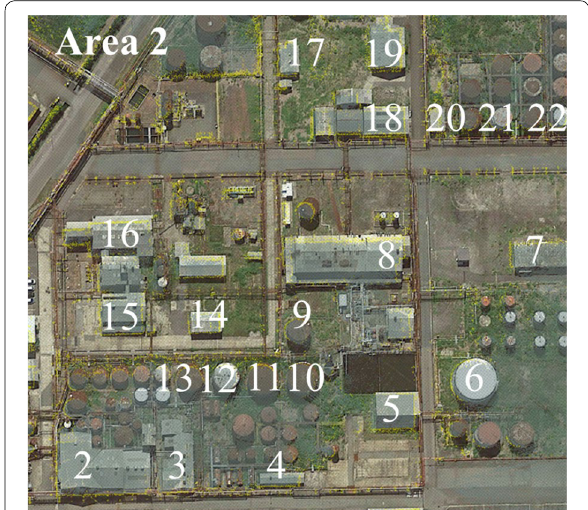
Fig. 6 Global consistency evaluation using an aerial map as a refer- ence. Each building position in the 2D map (yellow) was